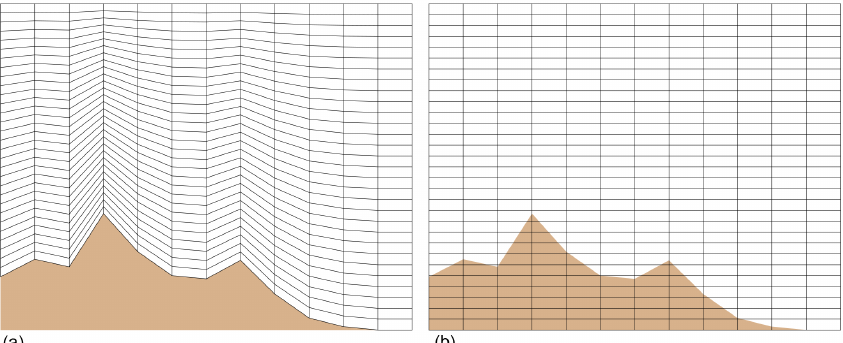
Figure 8. (a) A terrain-following coordinate passing over rough topography. (b) A cut-cell coordinate used for representing the same topog-